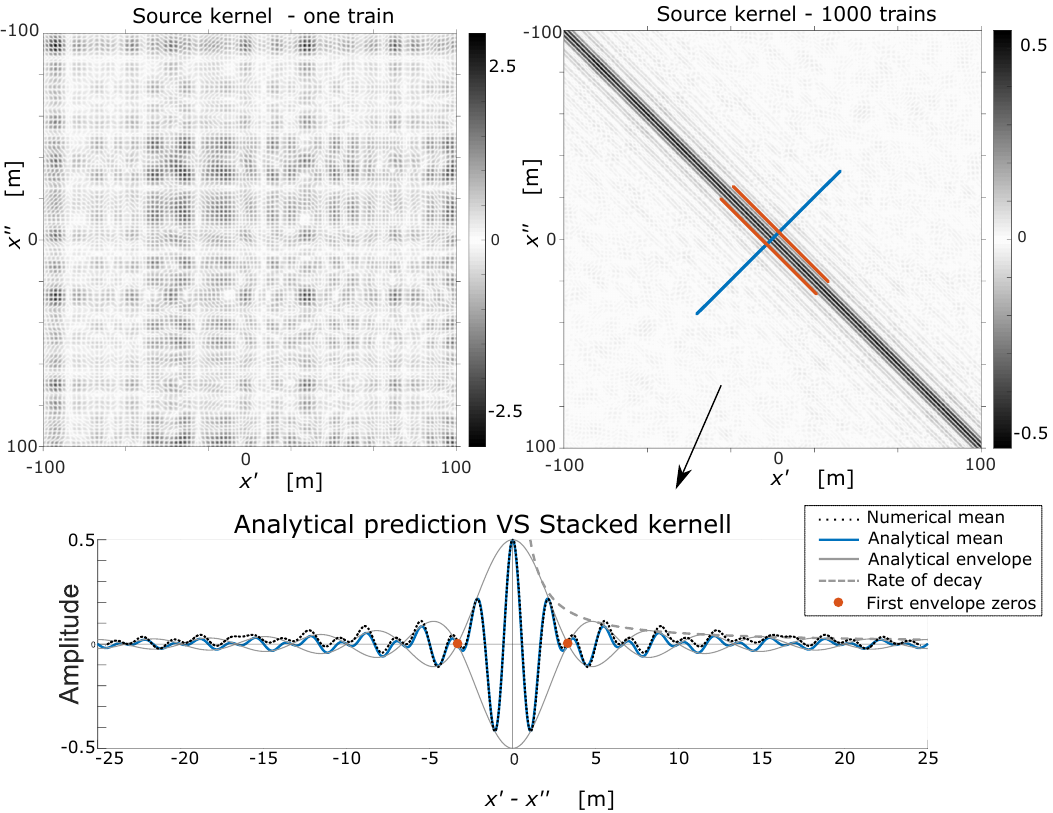
Figure 4. Example of the structure of the source kernel ˆ F ∗ ( x (cid:48) , ω ) ˆ F ( x (cid:48)(cid:48) , ω ) and the stacking average kernel (cid:104) ˆ F ∗ ˆ F (cid:105) ( x (cid:48) , x (cid:48)(cid:48) , ω ) = (cid:10) ˆ (cid:11) F ∗ ( x (cid:48) , ω ) ˆ F ( x (cid:48)(cid:48) , ω ) derived in Equation (14). Top left panel shows the spatial part of source kernel (14) (that is, without including the frequency-dependent term | ˆ s ( ω ) | 2 ) as a function of the location of a single train of sources recorded at each receiver. The simulated train travels at 90 km/h and its spectrum ranges from 10 Hz to 25 Hz. The top-right panel shows the corresponding kernel after stacking 1000 source train recordings each five minutes long. The bottom panel compares the numerical anti-diagonal section in black dashes, extracted from the numerical mean in the top-right panel, with the prediction given by Equation (14) in blue, as well as its analytical envelope in solid gray and the rate of decay in dashed gray, in terms of the signed spatial discrepancy x (cid:48) − x (cid:48)(cid:48) , where the parametrization x (cid:48) = ( x (cid:48) , 0 ) , x (cid:48)(cid:48) = ( x (cid:48)(cid:48) , 0 ) has been used. The rate of decay is derived from the envelope of the sinc factor in Equation (14). The orange dots highlight the first pair of zeros of the analytical envelope, capturing the energy around the mean. The radius (cid:101) will be taken to be the distance between these